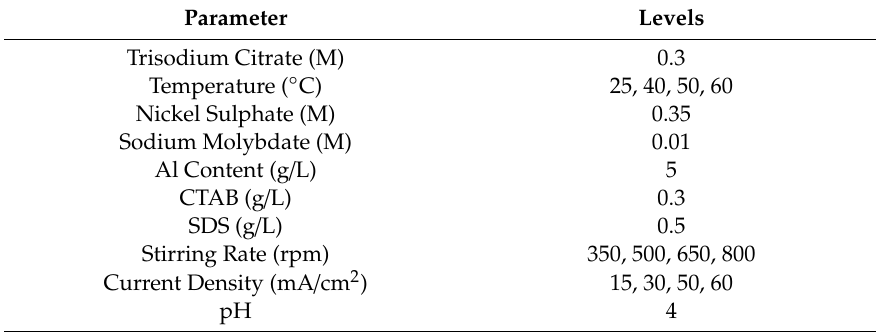
Table 1. The bath’s chemical composition, and operating parameters and their